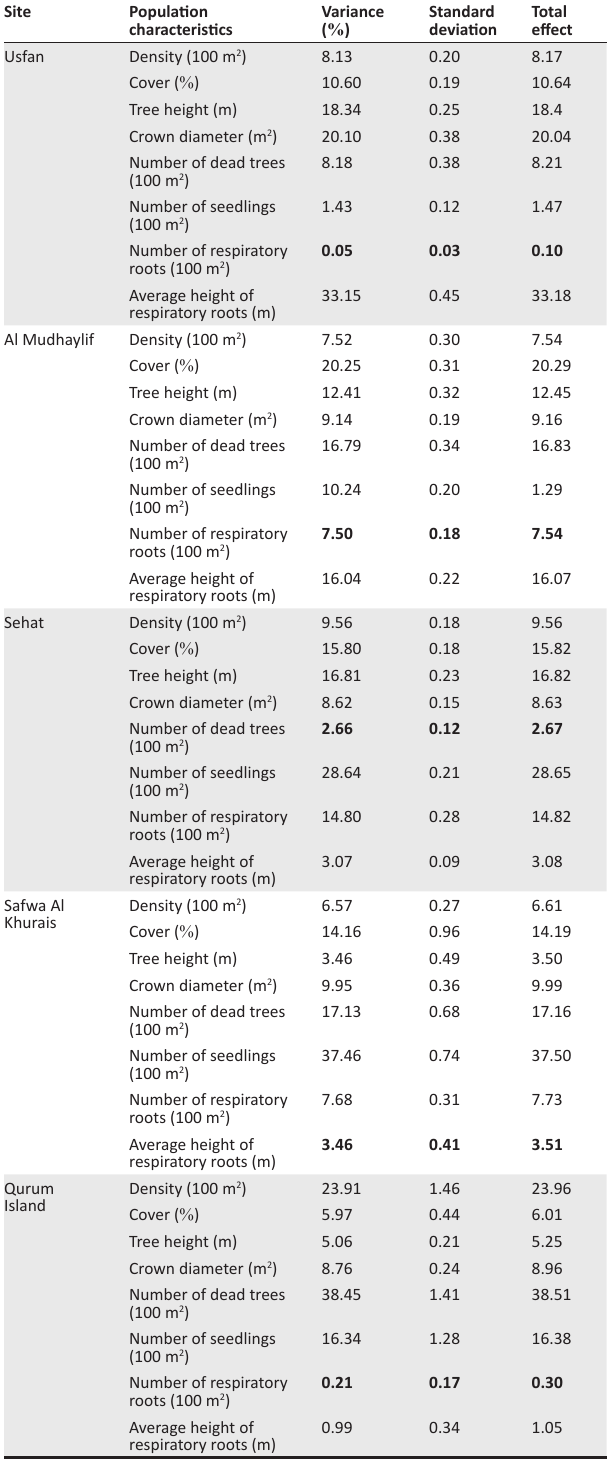
TABLE 1: Population characteristics and sensitivity analysis in the five study sites. Site Population